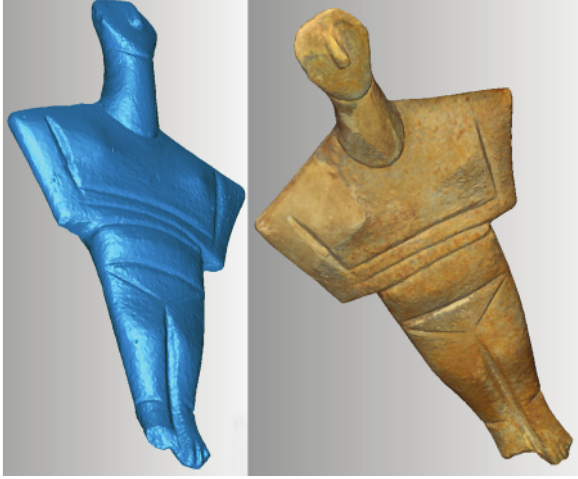
Figure 16. Polygon model of a female fi gurine with